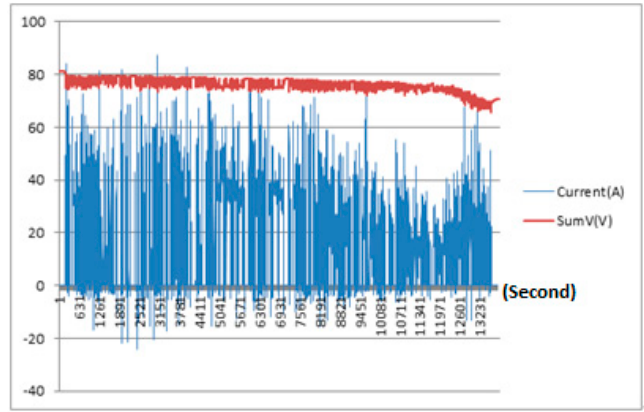
Figure 11. Histories of battery voltage and current.